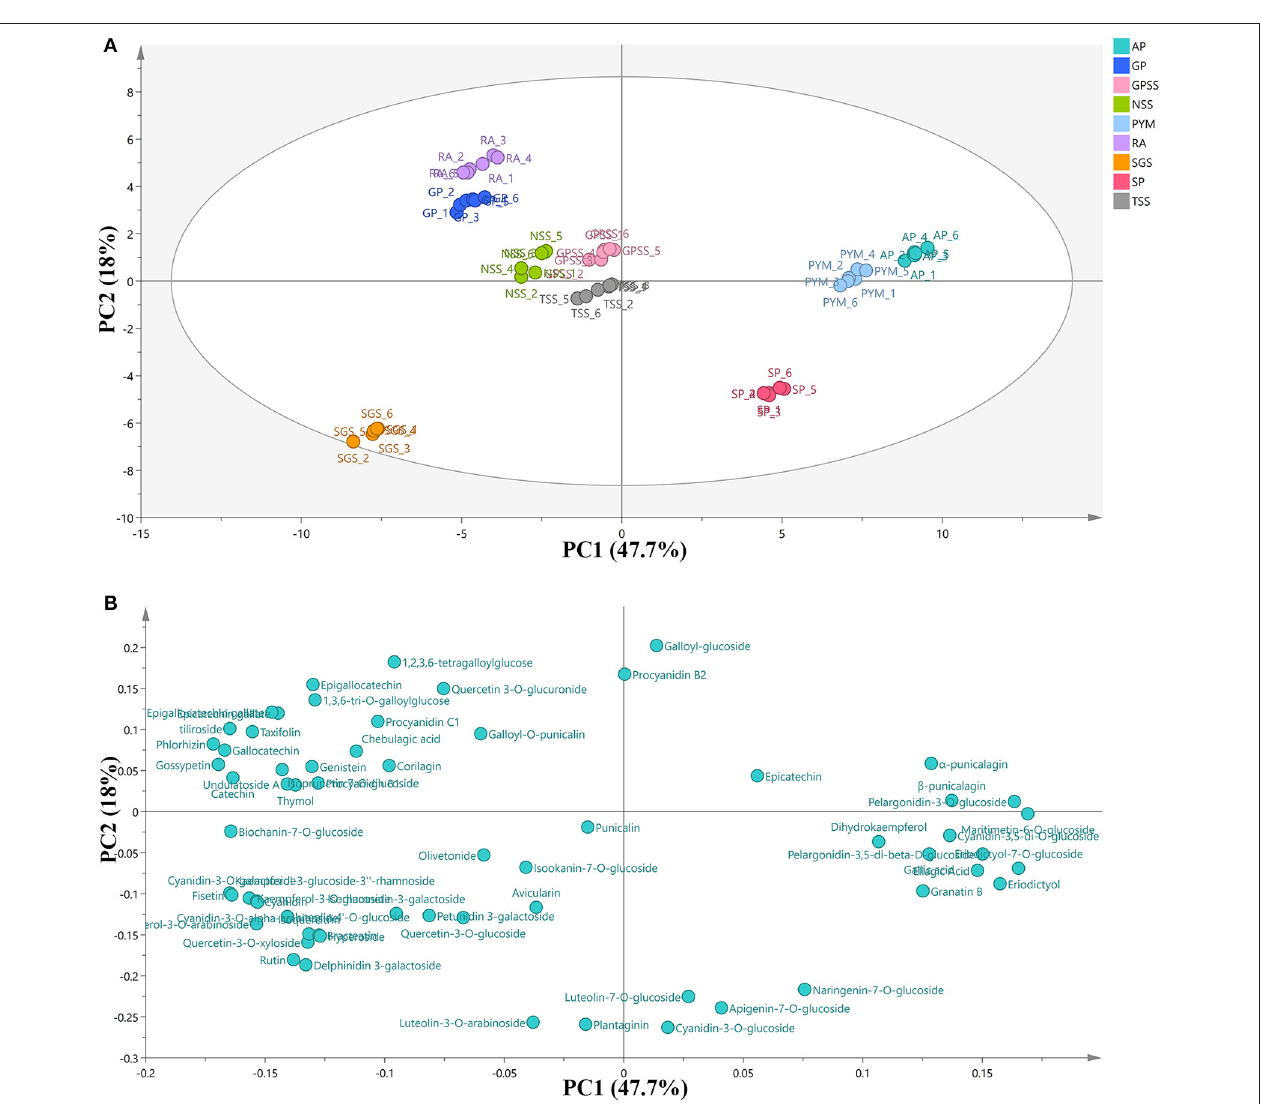
FIGURE 3 | PCA scores plot (A) and loading plot (B) of phenolic composition in nine cultivars. RA, Red Agate; TSS, Tunisian Soft Seed; SGS, Sweet with Green Seed; GPSS, Green Peel Soft Seed; GP, Green Peel; NSS, Net Skin Sweet; PYM, Piyaman; AP, Acidic Pomegranate; SP, Sweet Pomegranate; PCA, principal component